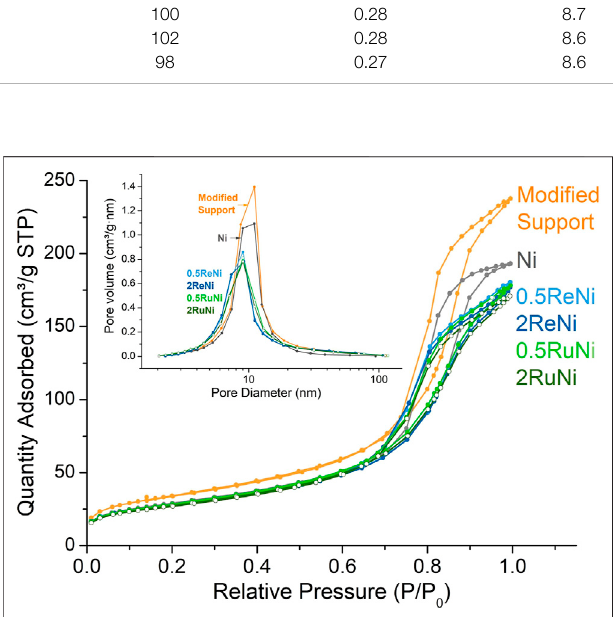
FIGURE 1 | Adsorption – desorption isotherms and pore size distribution of the synthesized